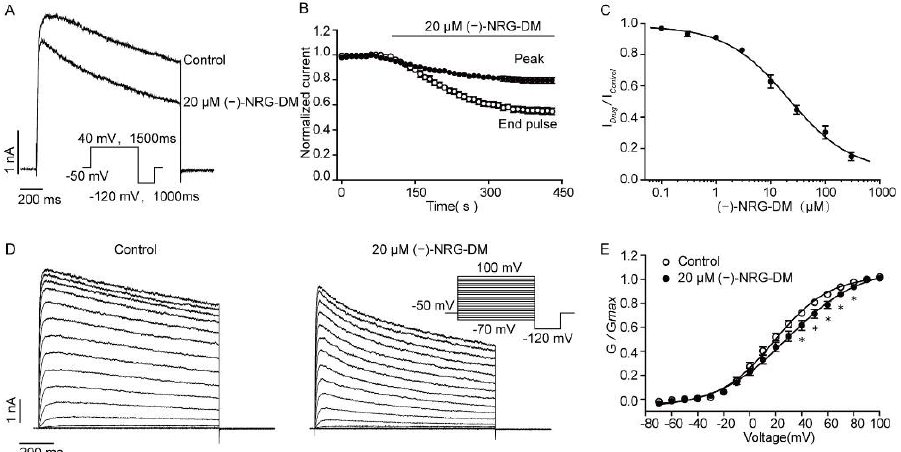
Figure 7. Inhibitory effects of ( − )-NRG-DM on Kv2.1 channels heterologously expressed in CHO cells. ( A ) Representative Kv2.1 current traces in the absence and presence of 20 µ M ( − )-NRG-DM (Inset) The recording protocol. ( B ) Time course of peak and end-pulse currents of Kv2.1 channels before and after perfusion of 20 µ M ( − )-NRG-DM. ( C ) The dose–response curve of ( − )-NRG-DM on Kv2.1 channel. The IC 50 value was 21.17 ± 0.11 µ M ( n = 5). ( D ) Representative activation current traces of Kv2.1 channels in absence and presence of 20 µ M ( − )-NRG-DM (Inset) The recording protocol. ( E ) Activation curves of Kv2.1 channels with or without 20 µ M ( − )-NRG-DM ( n = 5). Statistical significance: * p ≤ 0.05.